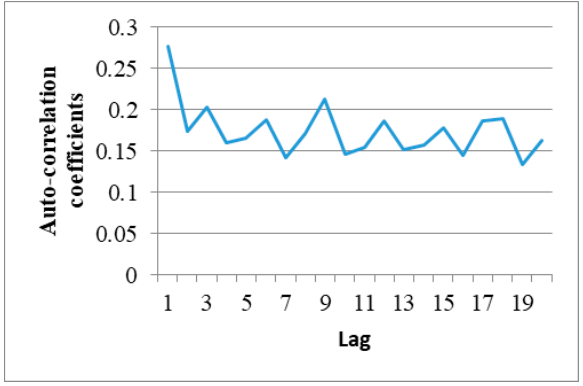
Figure 8. Autocorrelation coefficients of received data in time interval of 20/512 s within first minutes (21:45) of trace obtained in the sixth hour.